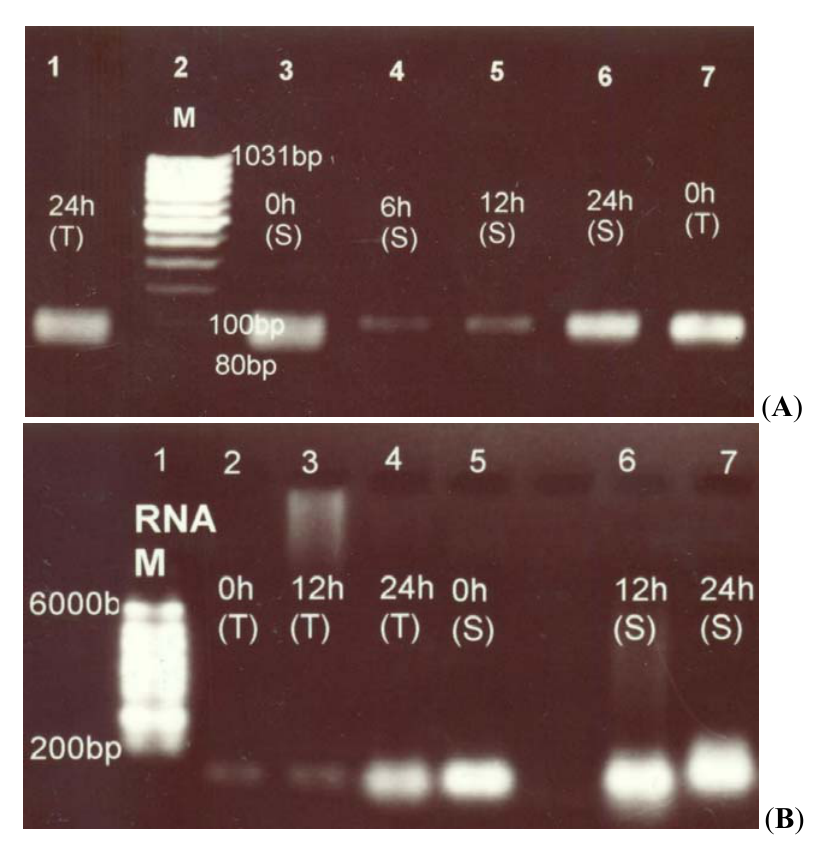
Figure 2. Pyrroline-5-carboxylate synthetase1 (P5CS1) gene expression in root and shoot tissues of salt-tolerant and salt-sensitive canola lines. ( A ) P5CS1 gene expression in root tissues of two contrasting canola lines at different time intervals after salt-treatment. ( B ) P5CS1 gene expression at different time intervals in shoot tissues of two contrasting canola lines. M is the short range DNA marker with last band of 200